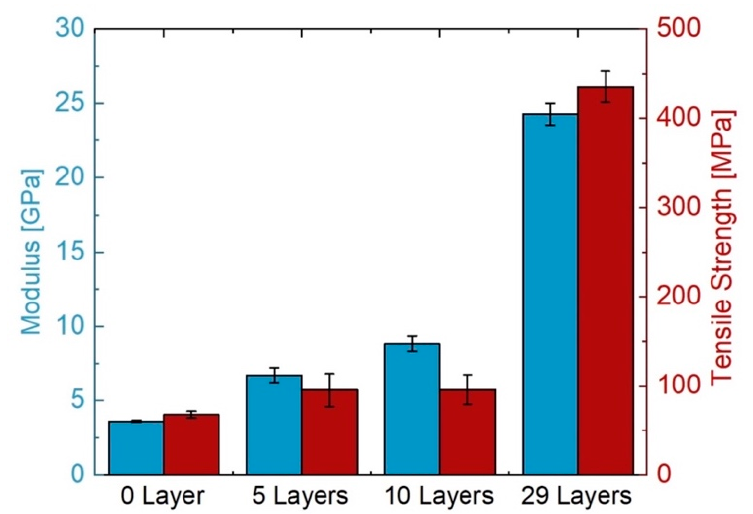
Figure 10. Mechanical properties of transparent composites in comparison to the unfilled resin (0 Layer).